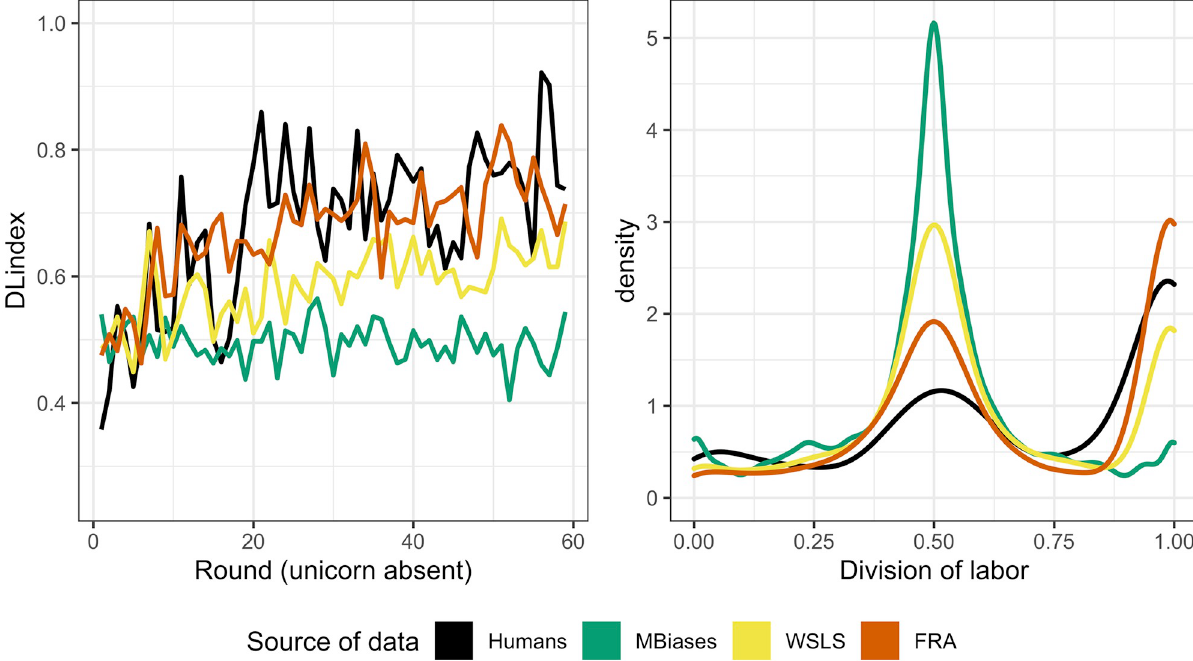
Fig 9. Behavioral data fit at the dyadic level. Left: DL INDEX per round, averaged over 45 dyads. Right: Kernel density estimate of DL INDEX